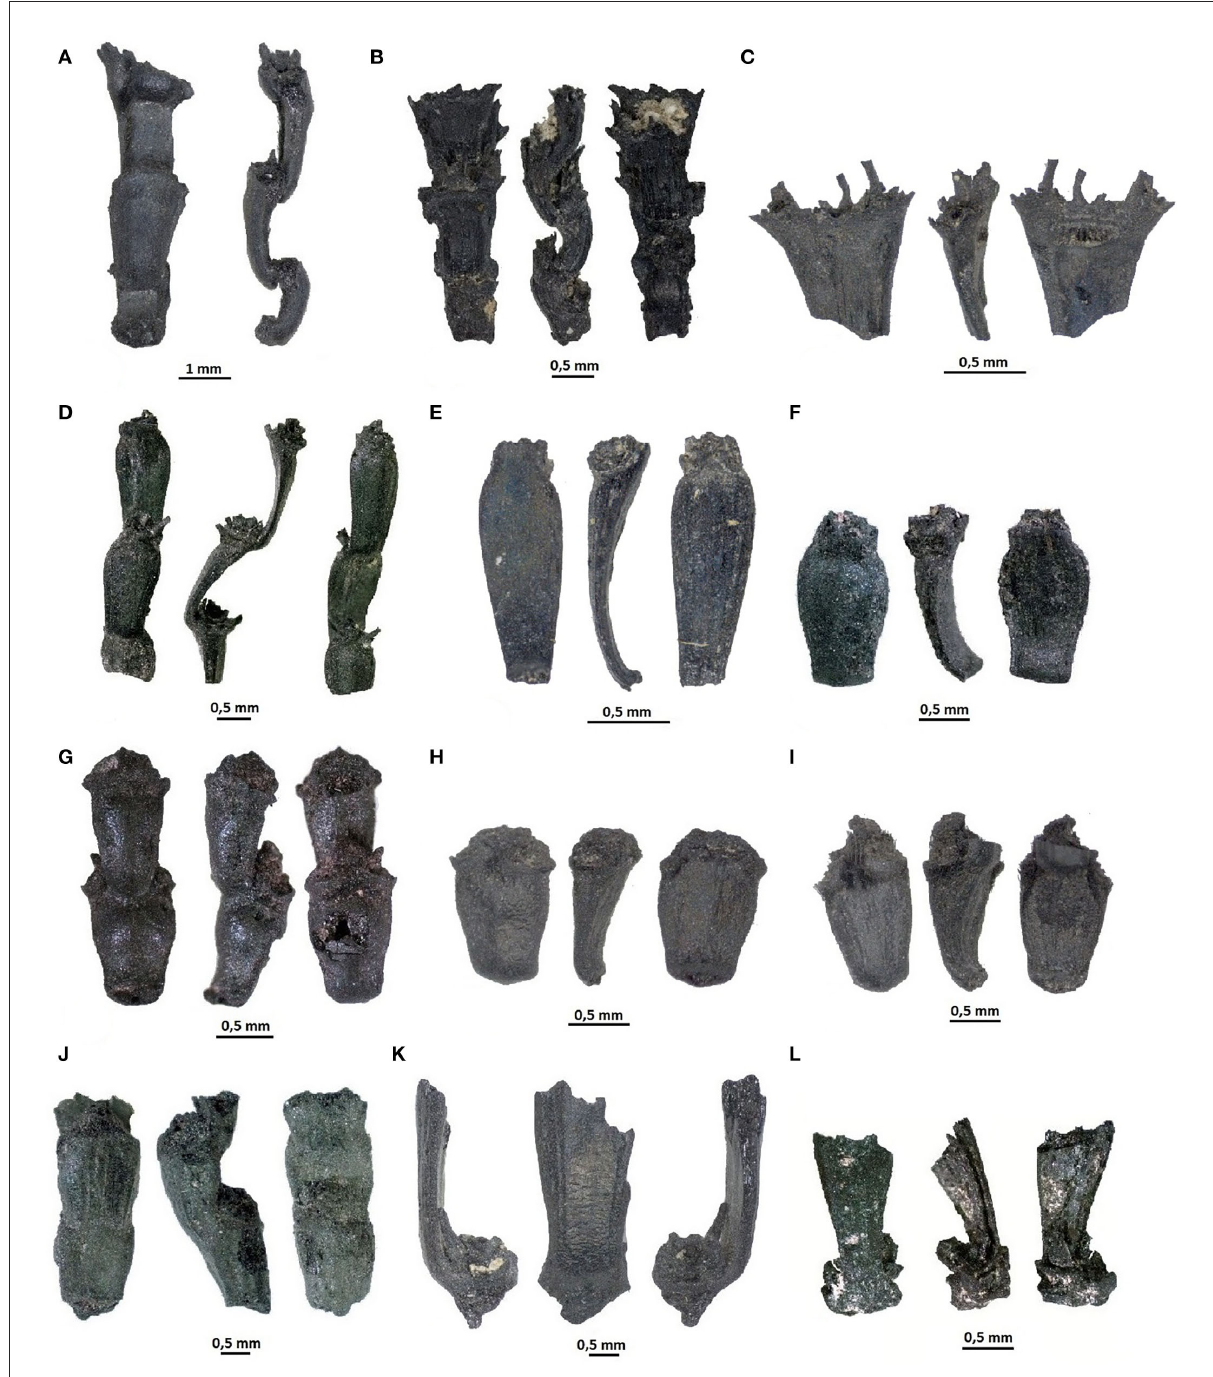
FIGURE5 Rachis internodes from Chap II site of Hordeum vulgare var. nudum (A–C) , Triticum aestivum (D, F) , Titicum carthlicum (E) , tetraploid free-threshing wheats cf. Triticum durum/turgidum (G–J) , and rachis internodes of possibly glume wheats (K,L)